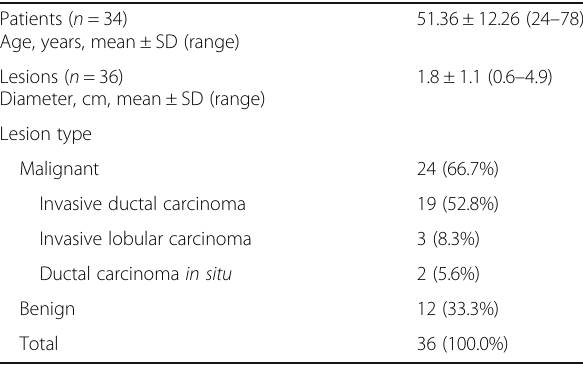
Patients ( n = 34) Age, years, mean ± SD